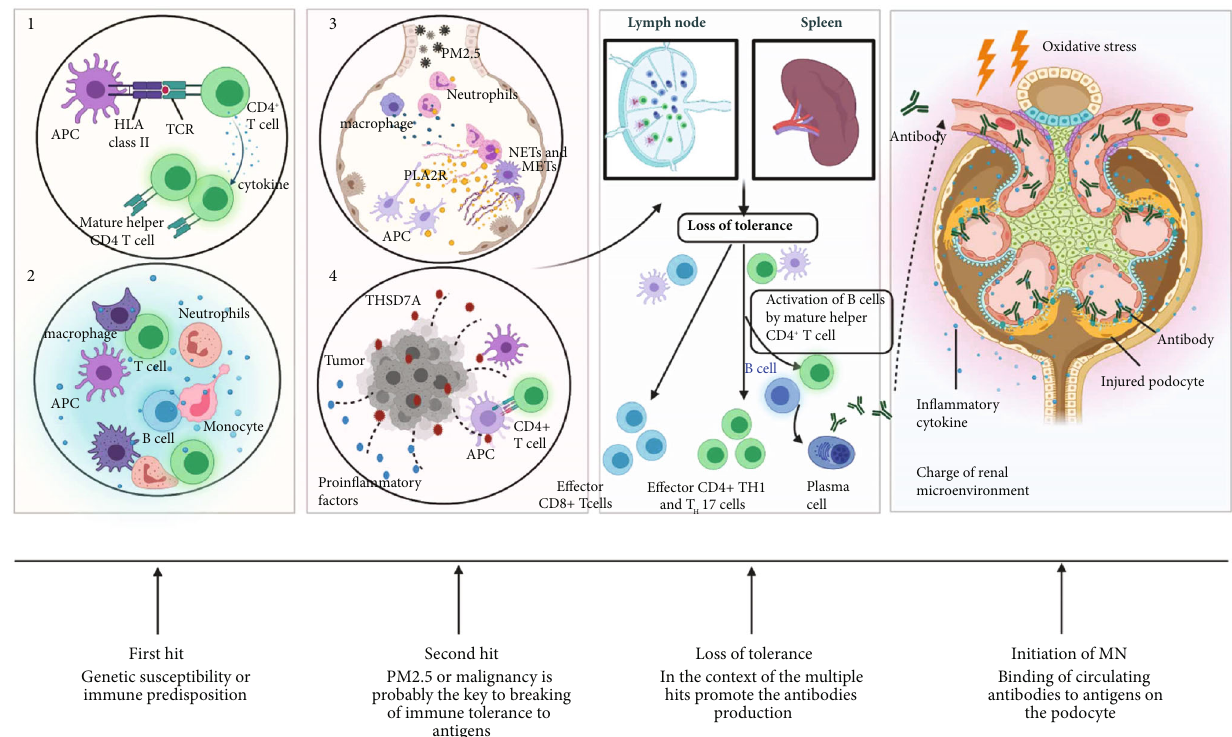
Figure 4: A multihit mechanism for the development of membranous nephropathy (MN). Genetic susceptibility or immune predisposition is thought to be involved in the ‘ fi rst hit ’ that probably drives the initial development of MN. Furthermore, PM2.5 or malignancy probably emerges as “ second hit ” that exerts an additive e ff ect on the activation of the immune response. In the context of multihit that causes loss of immune tolerance, T helper 1 (T 1) and 17 (T 17) cells are essential for autoantibody production. Once such an autoimmune response H H is established, proin fl ammatory cytokines would act to exacerbate the ongoing response. Besides, in fl ammation or pathogenic factors alter renal microenvironment, injure podocytes, and enhance the immunogenicity of autoantigens, which contribute to the development of MN. During the development of MN, circulating antibodies binding to the podocyte may be a perfect storm, rather than a straight forward conformeropathy. ① Risk allele associated with MN. ② Immune predisposition. ③ PM2.5 induces extrarenal phospholipase A2receptor (PLA2R) exposure to immune cells. ④ Malignancy induces thrombospondin domain-containing 7A (THSD7A) overexpression. Abbreviations: APC: antigen-presenting cell; HLA: human leukocyte antigen; TCR: T cell receptor; NETs: neutrophil extracellular traps; METs: macrophage extracellular